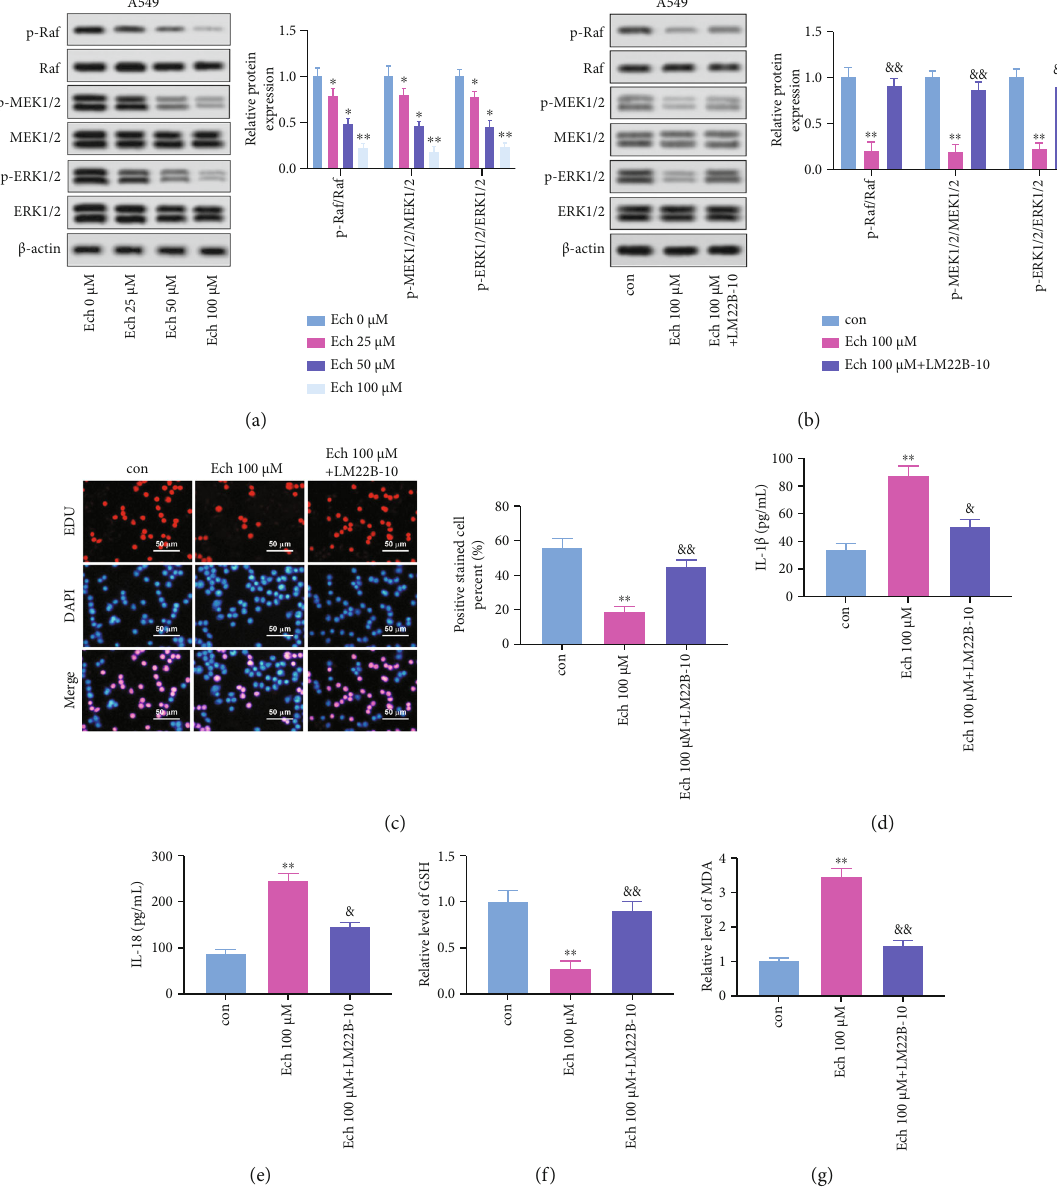
Figure 4: Ech restrained the malignant phenotypes of NSCLC cells by inhibiting Raf/MEK/ERK signaling pathway activation. (a) The expression of Raf/MEK/ERK signaling pathway proteins, c-Myc, and c-Fos in A549 cells was detected by western blotting. (b) The phosphorylation of the Raf/MEK/ERK signaling, c-Myc, and c-Fos was measured by western blotting in A549 cells treated by Ech with or without LM22B-10. (c) EdU staining of A549 cells and EdU-positive cell proportion. (d, e) Levels of IL-1 β and IL-18 in cell culture supernatants were assessed by ELISA. (f, g) Ech decreased GSH and increased MDA. Bar = 50 μ m . Data were represented as mean ± SD and represent three replicated experiments. ∗ P < 0 : 05 versus Ech 0 μ M; ∗∗ P < 0 : 01 versus Ech 0 μ M; &, P < 0 : 05 versus Ech 100 μ M; &&, P < 0 : 01 versus Ech 100 μ